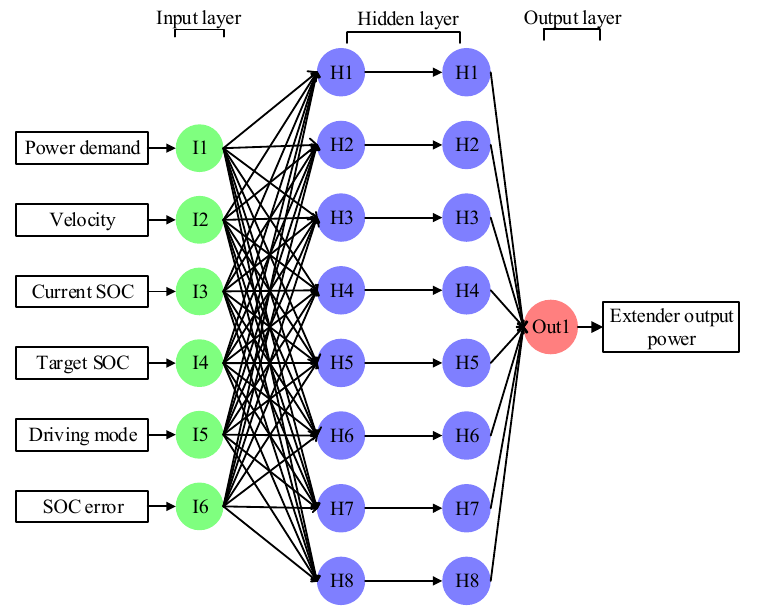
Figure 4. Neural network